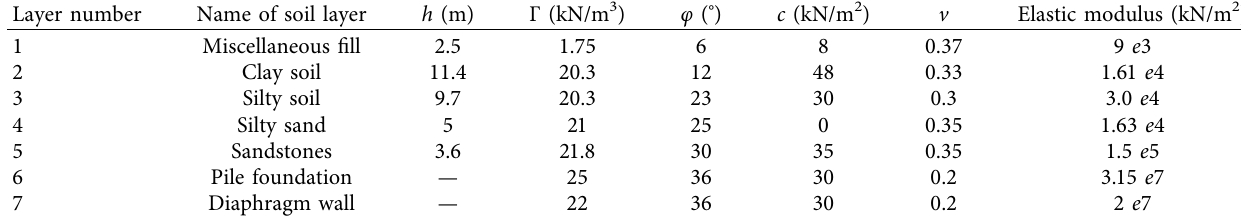
Table 1: Physical and mechanical properties of the wall